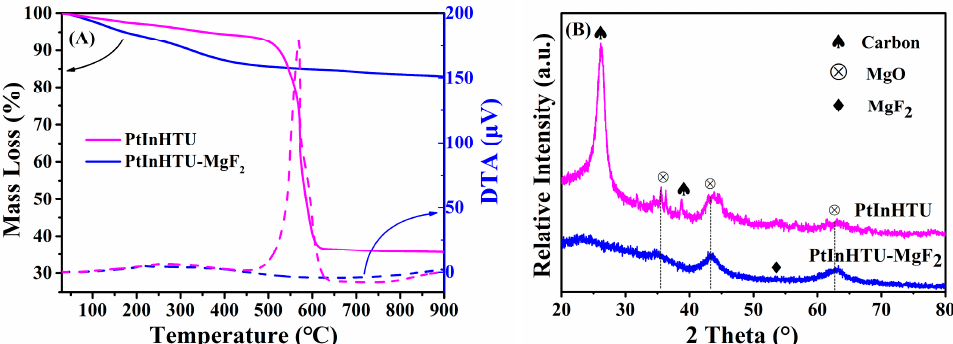
Figure 7. Thermogravimetric Analysis (TG-DTA) curves ( A ) and XRD patterns ( B ) of the spent catalysts.